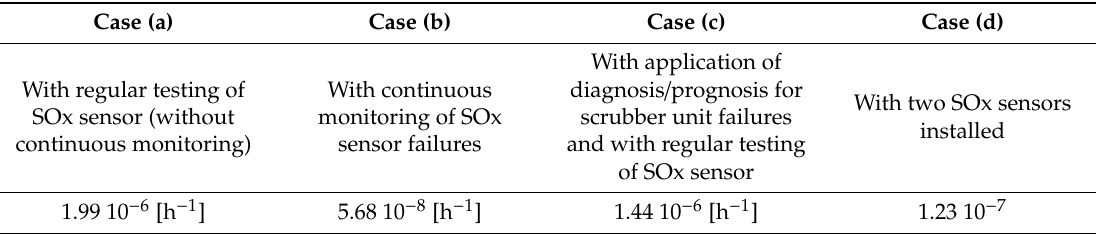
Table 8. Top event failure rate for di ff erent system functionalities.